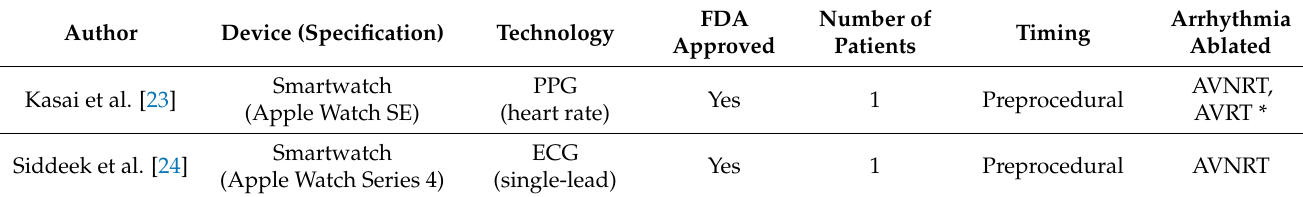
Table 2. Case series and studies evaluating the use of wearables before or after catheter ablation of arrhythmias. PPG = photoplethysmography; ECG = electrocardiogram; FDA = Food and Drug administration; AVNRT = atrioventricular nodal reentry tachycardia; AVRT = atrioventricular reentry tachycardia; AF = atrial fibrillation. * The patient recorded tachycardias with two different cycle lengths (tachycardia 1 at 400–374 ms and palpitations; tachycardia 2 at 333 ms and syncope).